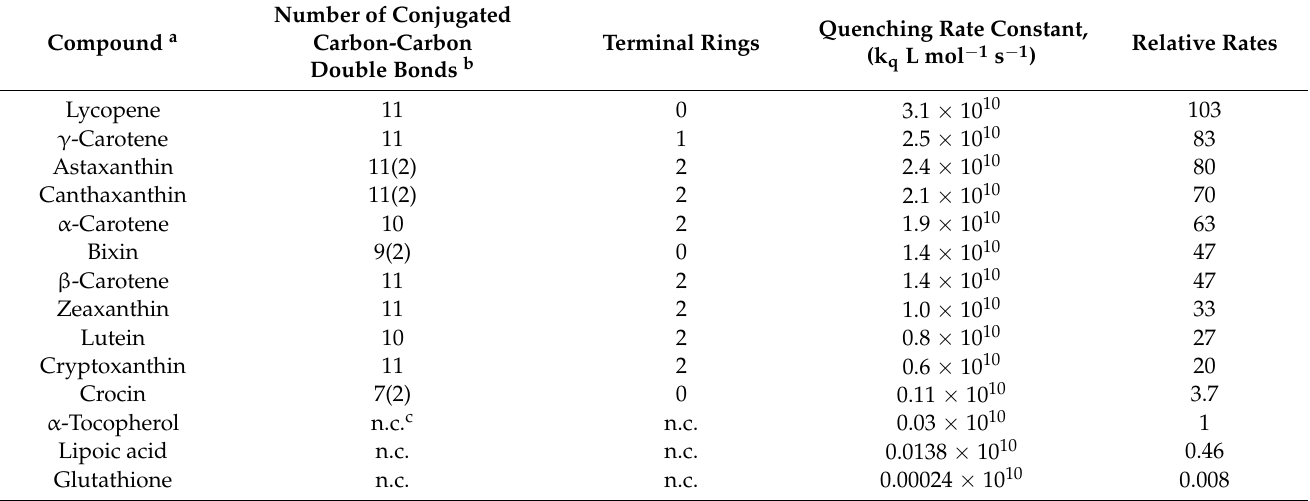
Table 3. The singlet oxygen ( 1 O 2 ) quenching ability of lycopene, other carotenoids and major